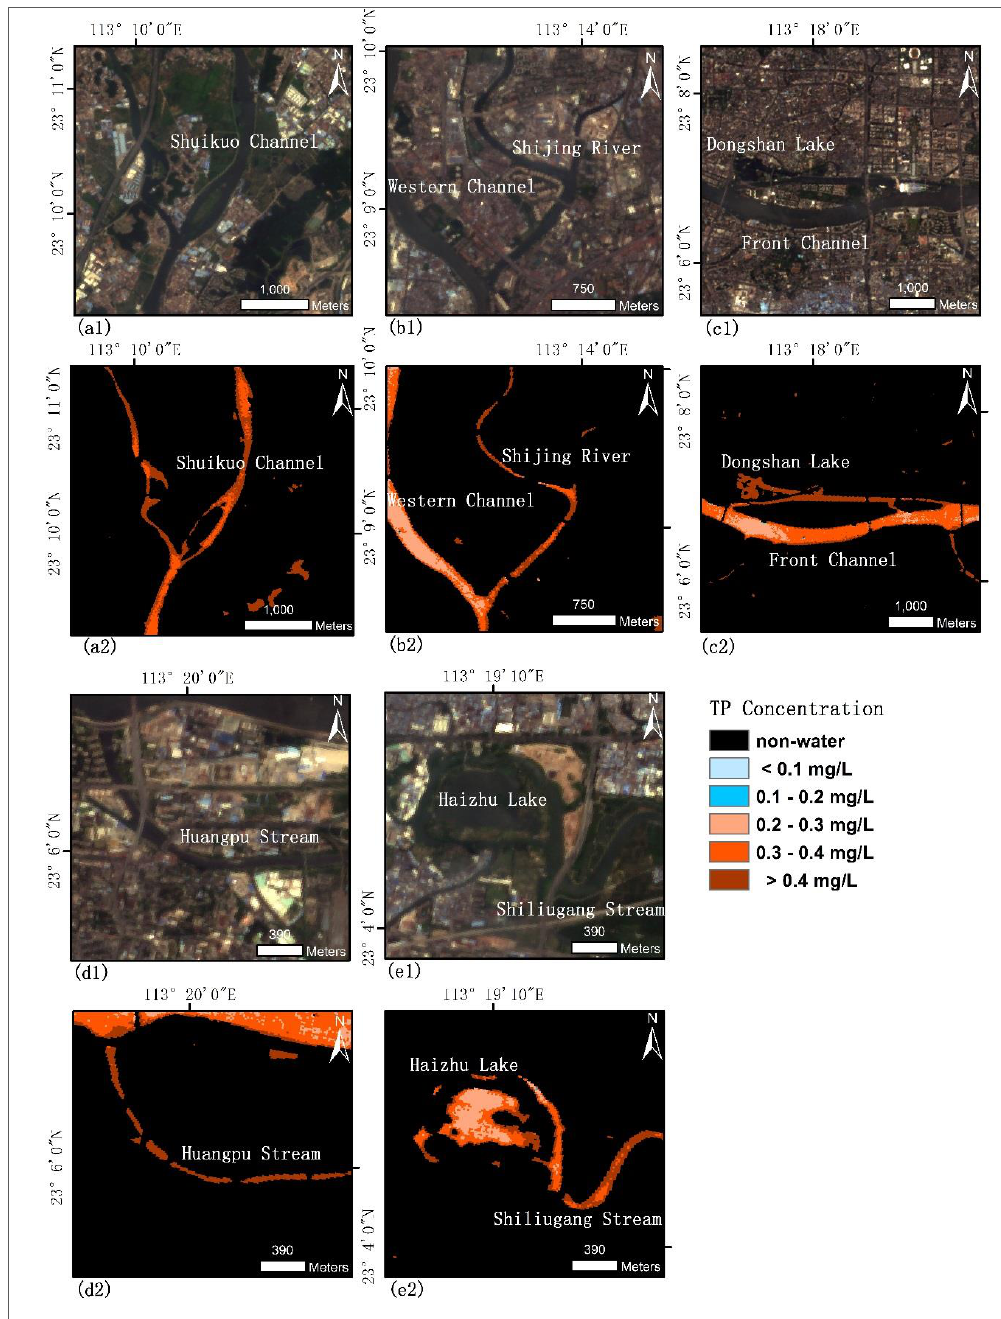
Figure 14. Local details of areas with high TP inversion concentration: (a) Shuikuo Channel (Nanhai District, Foshan), (b) Shijing River (Baiyun District, Guangzhou), (c) Dongshan Lake (Yuexiu District, Guangzhou), (d) Huangpu Stream (Haizhu District, Guangzhou), (e) Haizhu Lake and Shiliugang Stream (Haizhu District, Guangzhou).